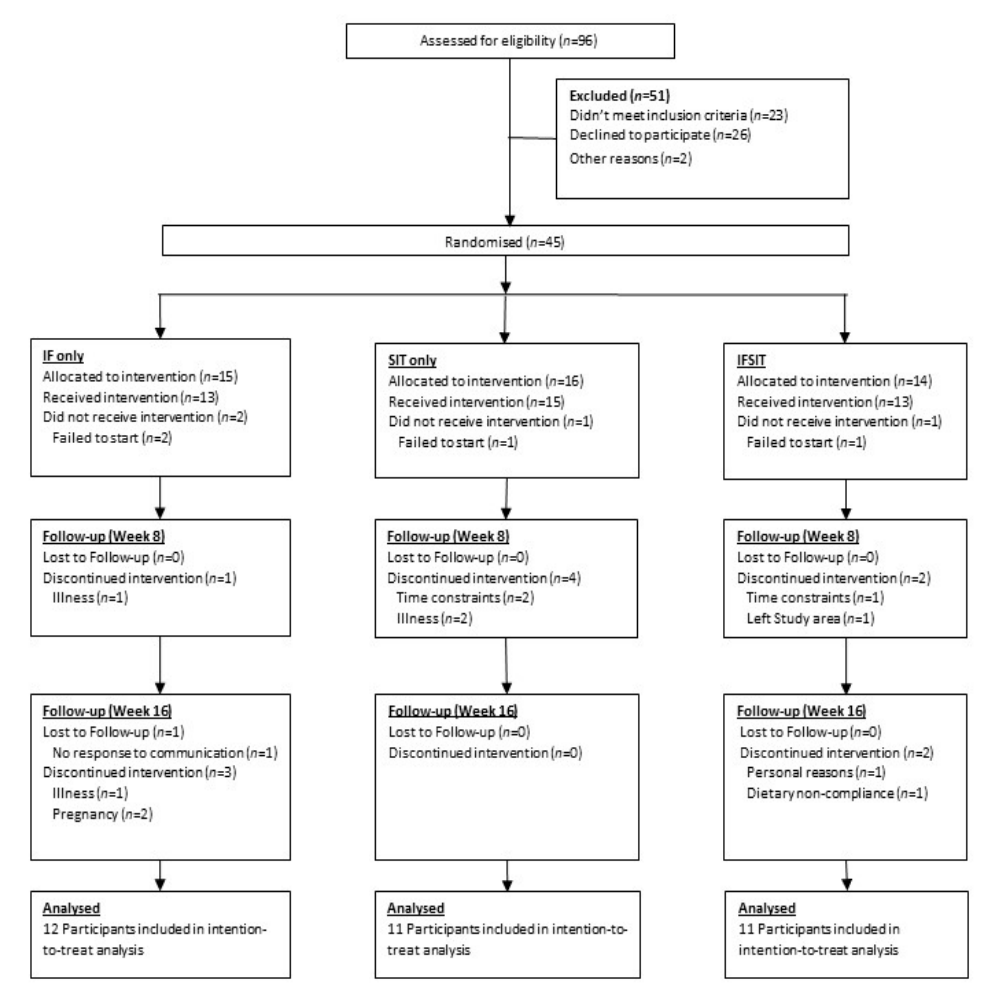
Figure 1. CONSORT diagram summarising the recruitment process, dropouts and